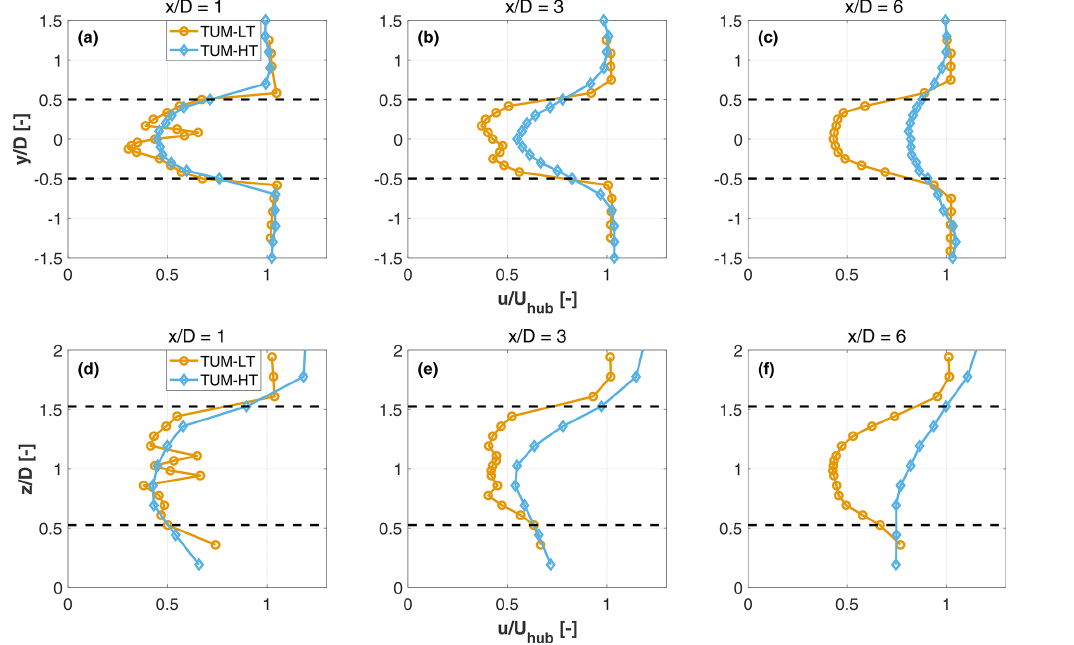
Figure 13. Horizontal (a–c) and vertical (d–f) profiles of the normalized streamwise velocity at several downstream distances, for sheared turbulent (TUM-HT) and uniform laminar (TUM-LT) inflow conditions. Black dashed lines indicate the rotor tips.